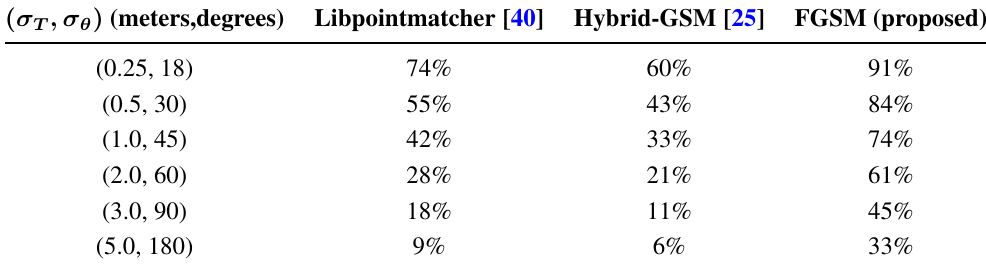
Table 3. A comparison of the proposed FGSM algorithm to previous methods in the case of both rotational and translational error. The percentage of trials that succeeded for various standard deviations in the rotational and translational components of the initial